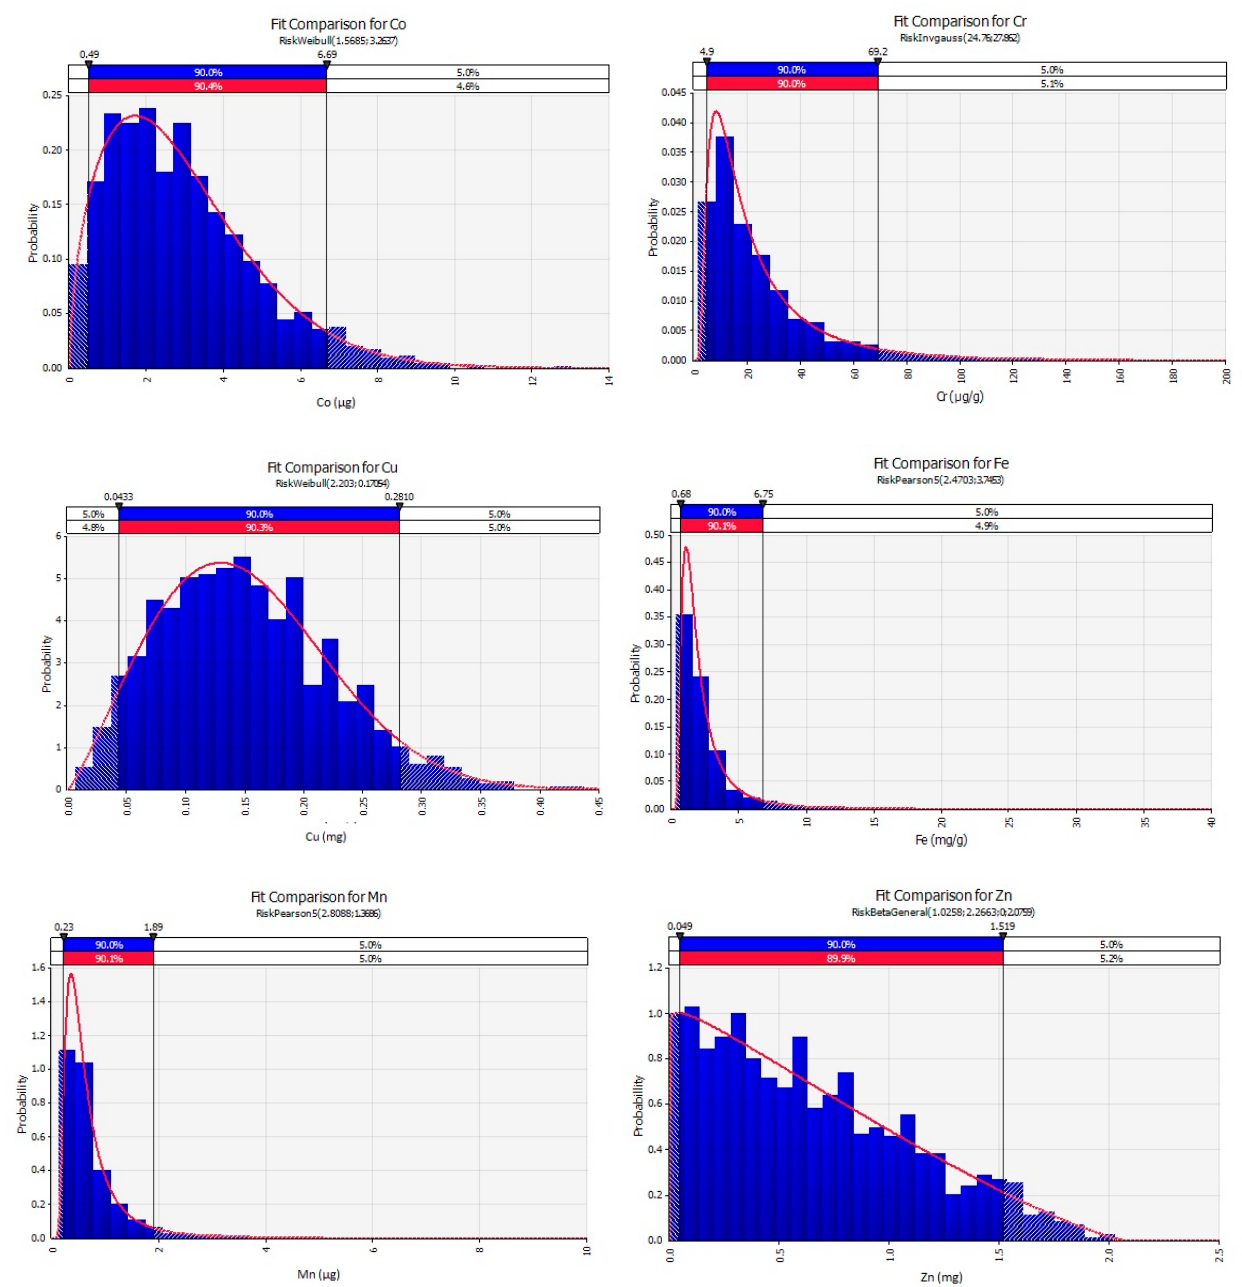
Figure 2. Simulated data and fitted probabilistic distribution for Co, Cr, Cu, Fe, Mn and Zn in conventional Brassicas.